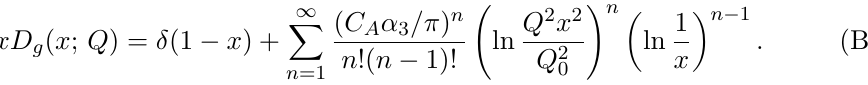
+ e . Similarly, on the right we see L R